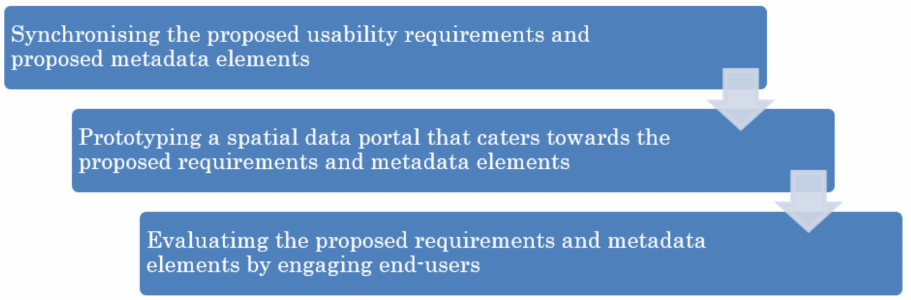
Figure 2. The methodology of the paper.